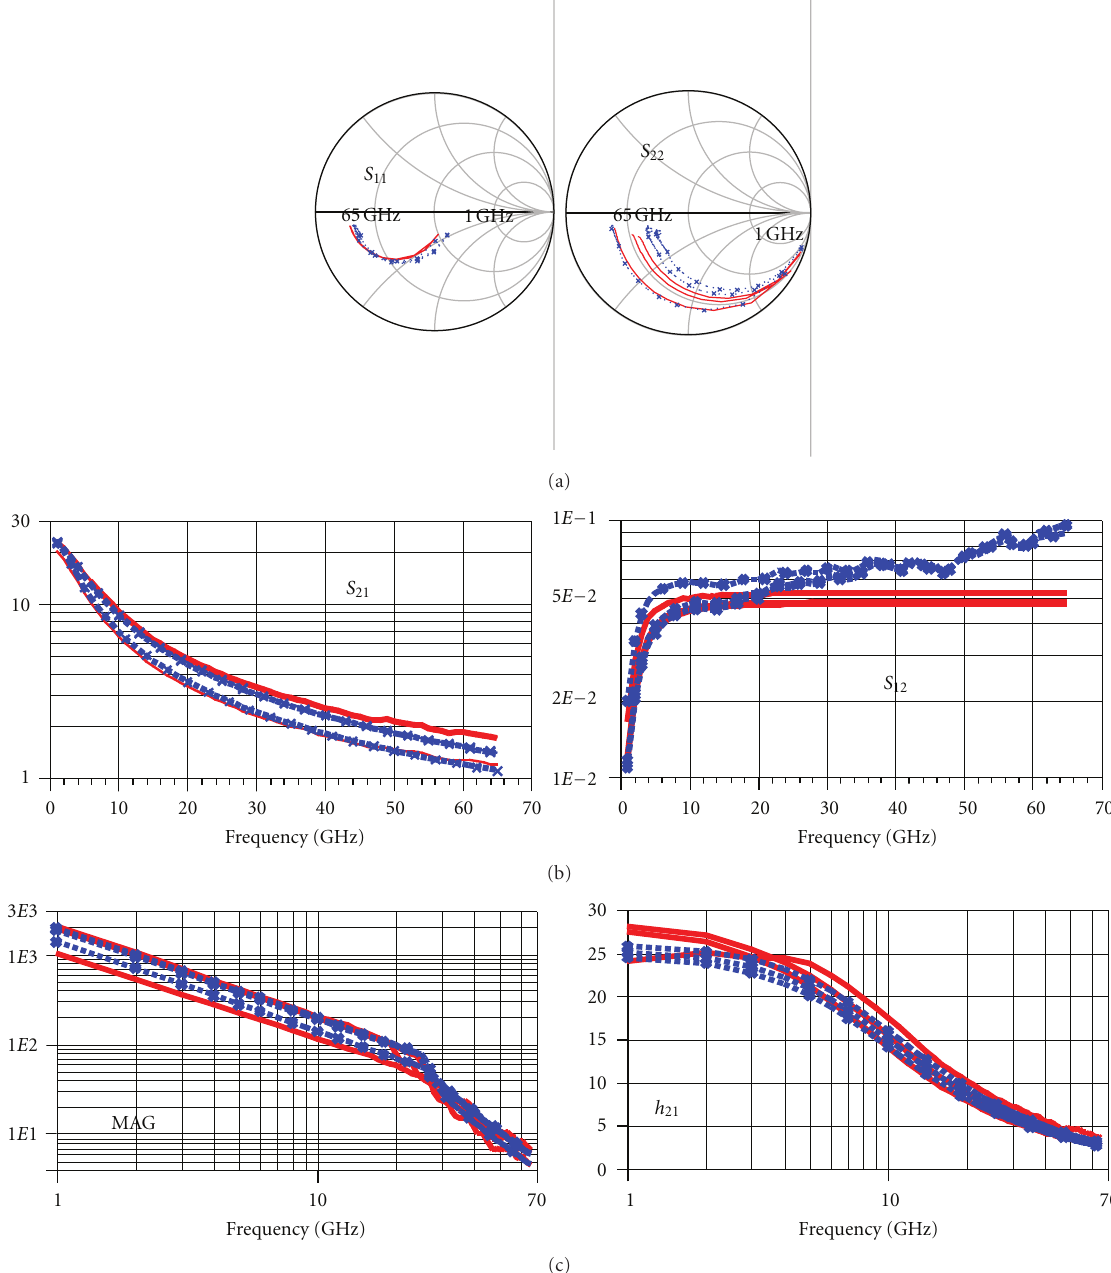
Figure 5: Comparison between model simulation results in red and measurements (blue cross) for the MAG, S 11 , S 12 , S 22 , S 21 , and h 21 parameters with I b = 2mA and V ce = 1 − 2 − 2 . 5